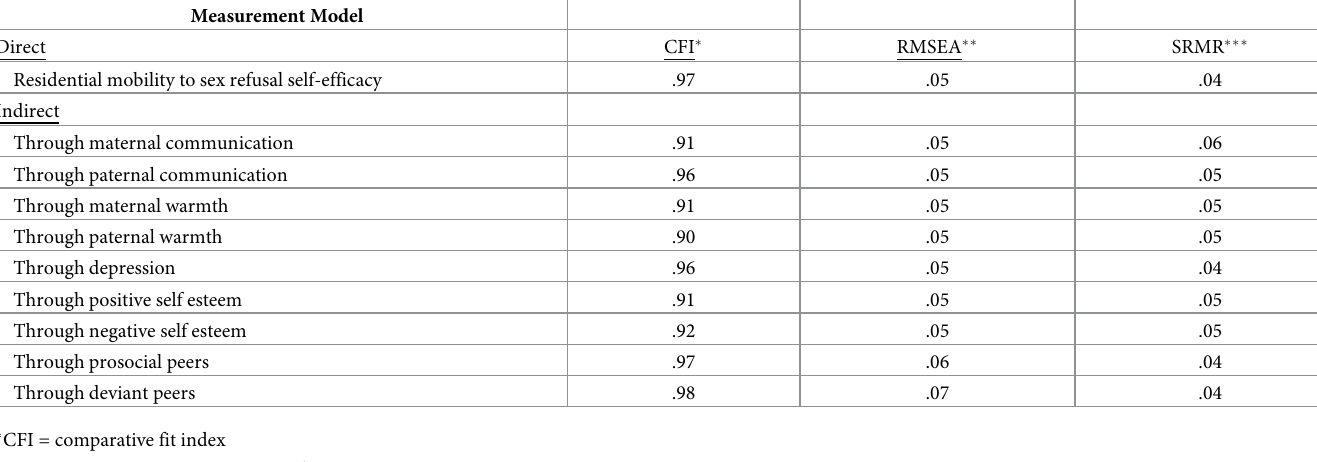
Table 2. Confirmatory factor analysis of the direct and indirect relationships of the exploratory